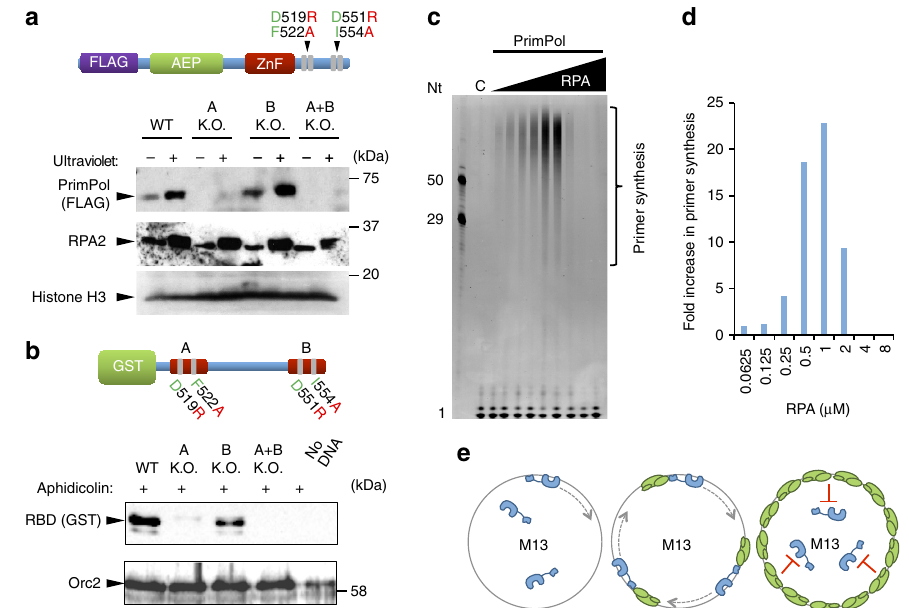
Figure 6 | RPA recruits PrimPol to stalled replication forks in vivo. ( a ) PrimPol’s RBM-A, but not RBM-B, is critical for recruitment to chromatin. Flp-In T-Rex-293 cells transfected with WTand RBM-A and B mutant PrimPol constructs were either mock ( (cid:2) ) or ultraviolet-C (30Jm (cid:2) 2 ) ( þ ) irradiated before separation into Triton X-100 (0.5%) soluble and insoluble fractions. Samples were analysed by western blot alongside whole-cell extracts. Only insoluble samples are presented here, whole-cell extracts and soluble blots can be found in Supplementary Fig. 6. ( b ) PrimPol’s RBD is recruited to Xenopus